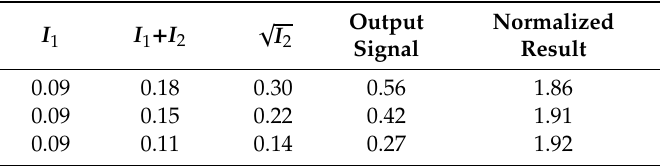
Table 1. The list of measured and calculated results, in